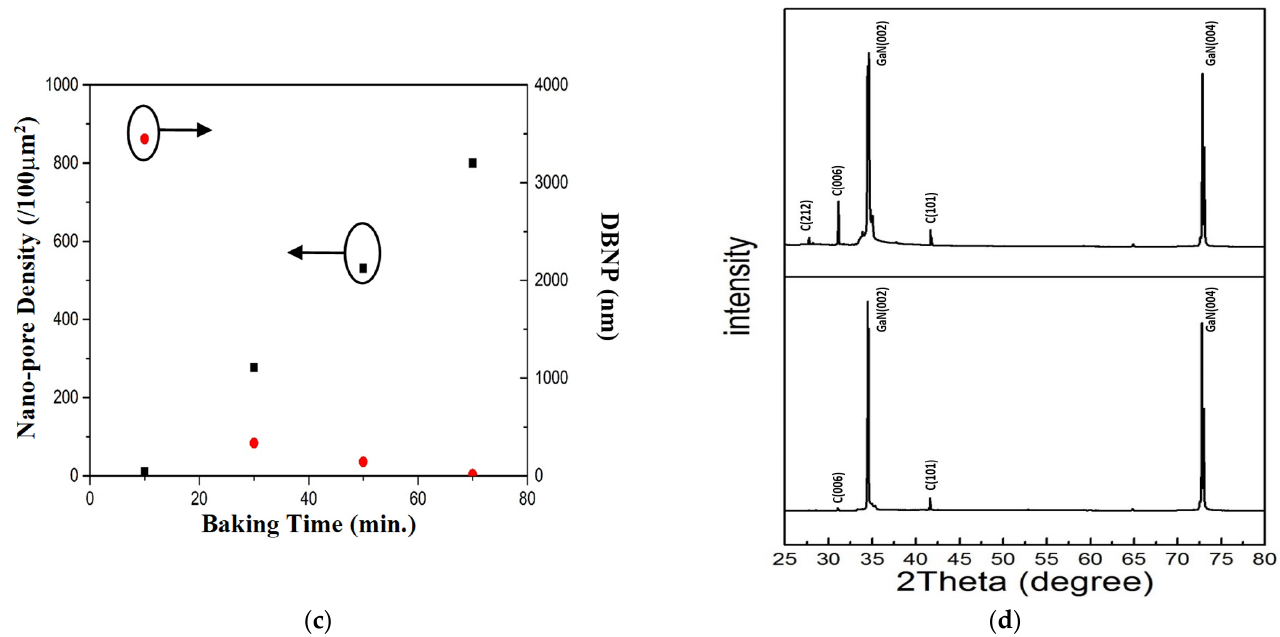
Figure 2. ( a ) Top view FESEM image of the photoresist on the p-GaN layer after being baked at 200 °C and etched using ICP-RIE. ( b ) The nano-pore density and DBNP in the photoresist baked at various temperatures for 30 min and then etched by the ICP process. ( c ) The nano-pore density and DBNP in the photoresist baked at a temperature of 240 °C for various times and then etched by ICP the process. ( d ) X-ray diffraction patterns of the photoresist on samples baked at 160 °C and 240 °C.